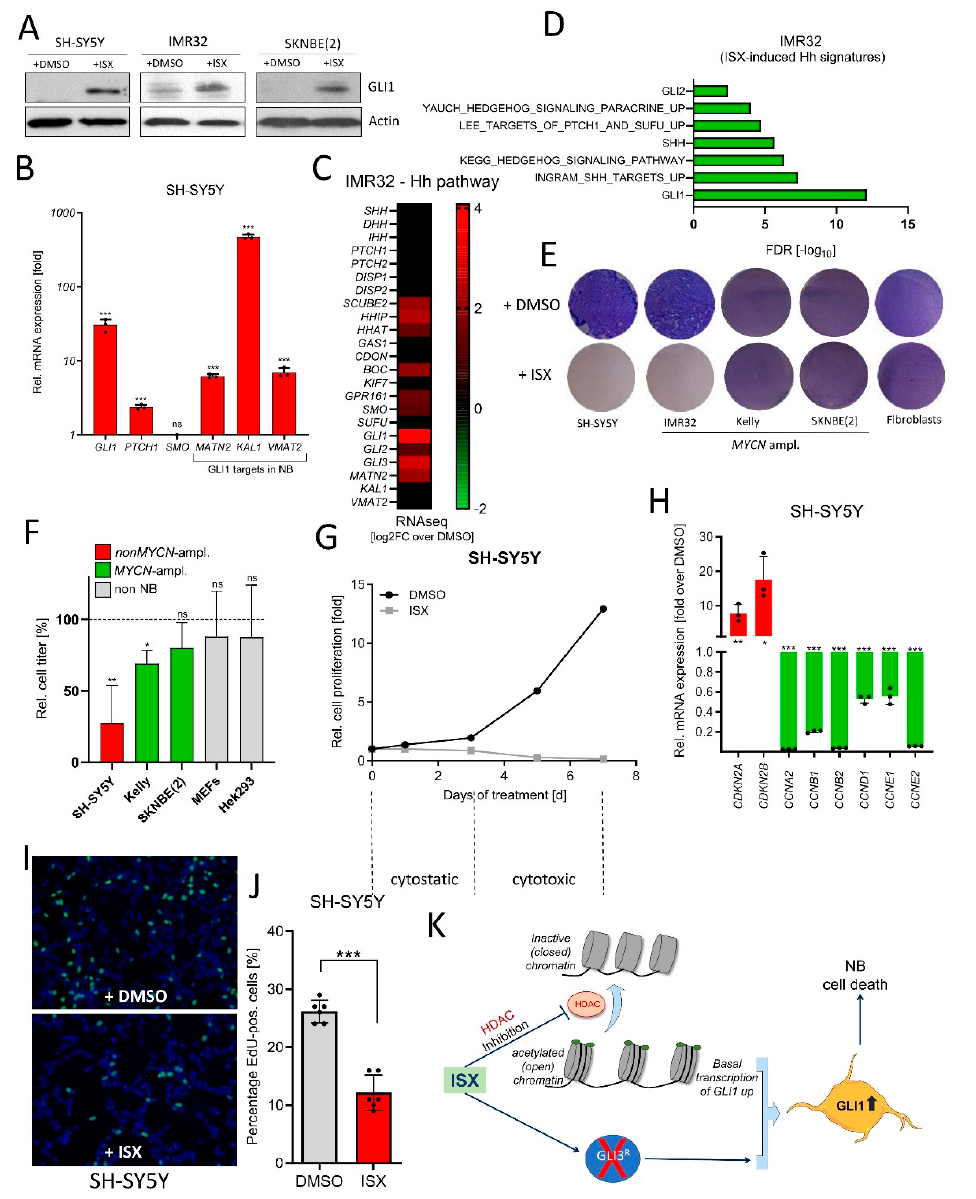
Figure 7. ISX blocks NB cell proliferation. ( A ) Western blot depicting GLI1 protein levels in two different human NB cell lines after ISX (20 µ M, 48 h) treatment. Shown are the representative results of one experiment of two. ( B ) Expression of Hh pathway genes (qPCR) in ISX (20 µ M, 48 h)-treated SH-SY5Y cells. Mean of n = 3 ± SD. ( C ) Expression (log2 fold change over DMSO) of Hh pathway genes (RNAseq) in ISX (20 µ M, 48 h)-treated IMR32 cells. ( D ) Hh-related transcriptome signatures (RNAseq) of ISX (20 µ M, 48 h)-treated IMR32 cells versus DMSO control. ( E ) Colony stain (Giemsa, blue) of the indicated cell lines exposed to DMSO or ISX (20 µ M) for 4–5 d. Fibroblasts were human pancreatic stellate cells (PSCs). Shown is one representative experiment of two. ( F ) Relative cell count changes in SH-SY5Y cells upon DMSO or ISX (20 µ M) treatment. Shown is the mean of n = 2 experiments. ( G ) Relative cell count changes in IMR32 cells upon DMSO or ISX (20 µ M) treatment. Shown is the mean of n = 2 experiments. ( H ) Changes in cell cycle gene expression (qPCR) in ISX (20 µ M, 48 h)-treated SH-SY5Y cells. Mean of n = 3 ± SD. ( I ) BrDU (EdU) labelling (green) of DMSO/ISX-treated SH-SY5Y cells. Nuclei appear in blue (DAPI). ISX concentration was 20 µ M; treatment time 24 h (last 4 h with 10 µ M EdU). ( J ) Quantification of EdU labelling experiment depicted in ( I ). Shown are two counted regions with at least 100 cells of each of n = 3 independent experiments ( ± SD). ( K ) General scheme on the mechanism of ISX function. ISX inhibits class I HDACs and removes GLI3 repressor, two events which might synergize to drive GLI1 expression. Significances were indicated as ns (not significant; p > 0.05), * p < 0.05, ** p < 0.01, *** p <